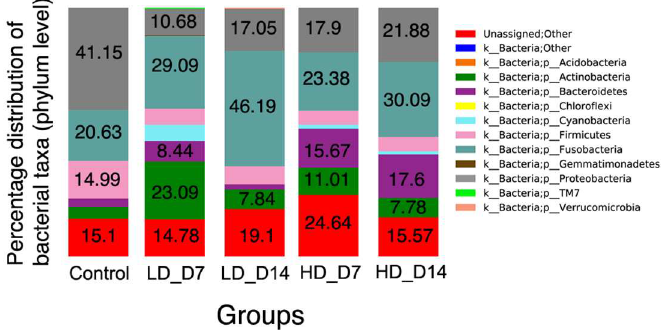
Fig 2. Bacterial community composition of Atlantic salmon skin in each experimental group. Bar chart of the mean relative abundance of phyla present in the salmon skin from the five different experimental groups. LD_D7: low-doseinfected day 7; LD_D14: low-doseinfected day 14; HD_D7: high-doseinfected day 7; HD_D14:high-dose infected day 14. Number represent the relative percentage of each phyla that had abundances greater than